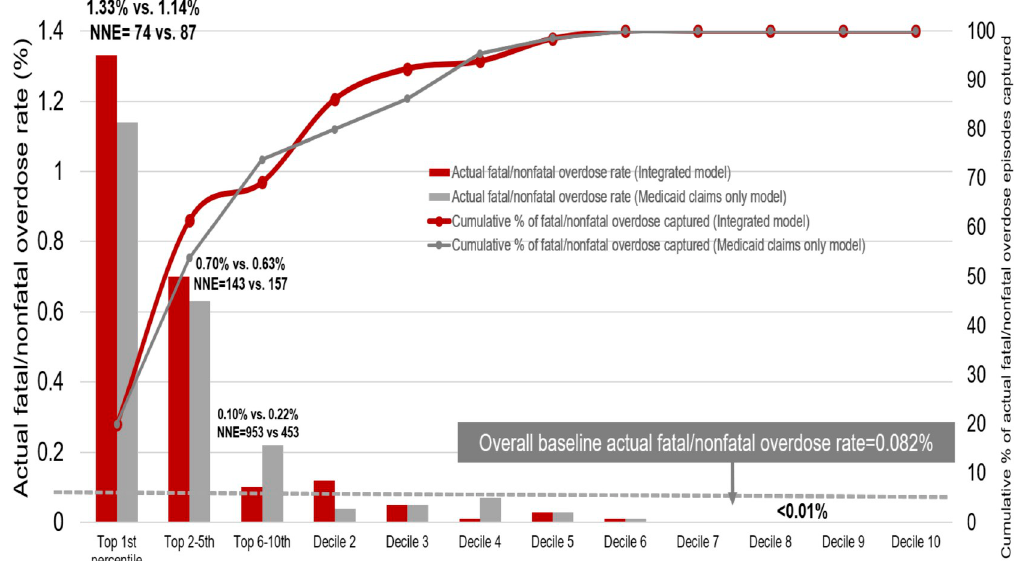
Fig 2. Opioid overdose identified by decile risk subgroup in the validation sample (n = 79,086) using gradient boosting machine: Integrated vs. Medicaid claim only models a . a : Based on the individual’s predicted probability of an opioid overdose (fatal/nonfatal) event, we classified beneficiaries in the validation sample into decile risk subgroups, with the highest decile further split into 3 additional strata based on the top 1 st , 2 nd to 5 th , and 6 th to 10 th percentiles to allow closer examination of patients at highest risk of developing